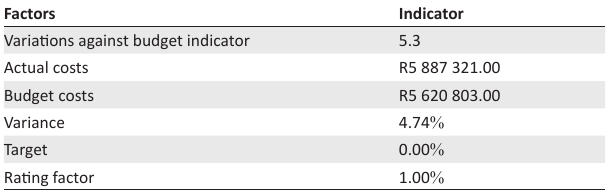
TABLE 3: Variations against budget: wages.